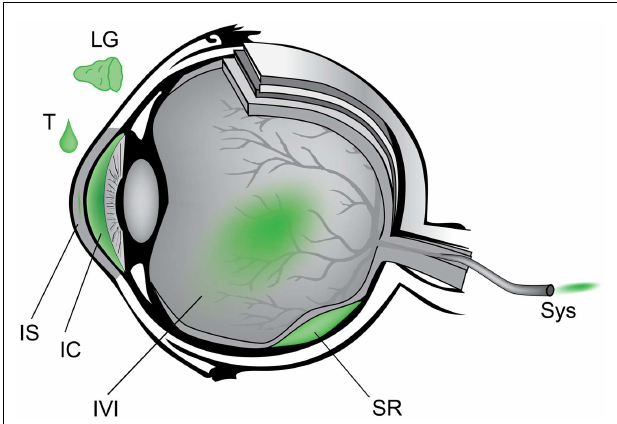
FIGURE 3 | Schematic of anatomic approach to administration of gene therapy vectors in the eye . Counterclockwise from upper left – LG, lacrimal gland;T, topical eye drop; IS, intra-stromal of cornea; IC, intra-cameral, i.e., anterior chamber; IVI, intravitreal; SR, sub-retinal; Sys,